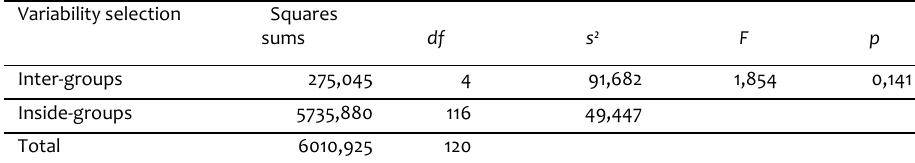
Table No. 5. Analysis of variances scores achieved by the teachers depending on the years of work experience at the scale established for assessment of the autocratic work style in the teaching